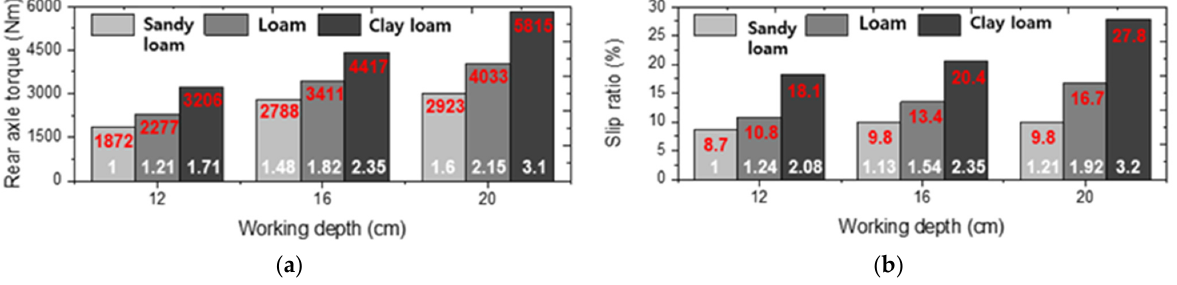
Figure 9. Comparison analysis by tillage depth and test sites: ( a ) rear wheel axle torque; ( b ) slip ratio.